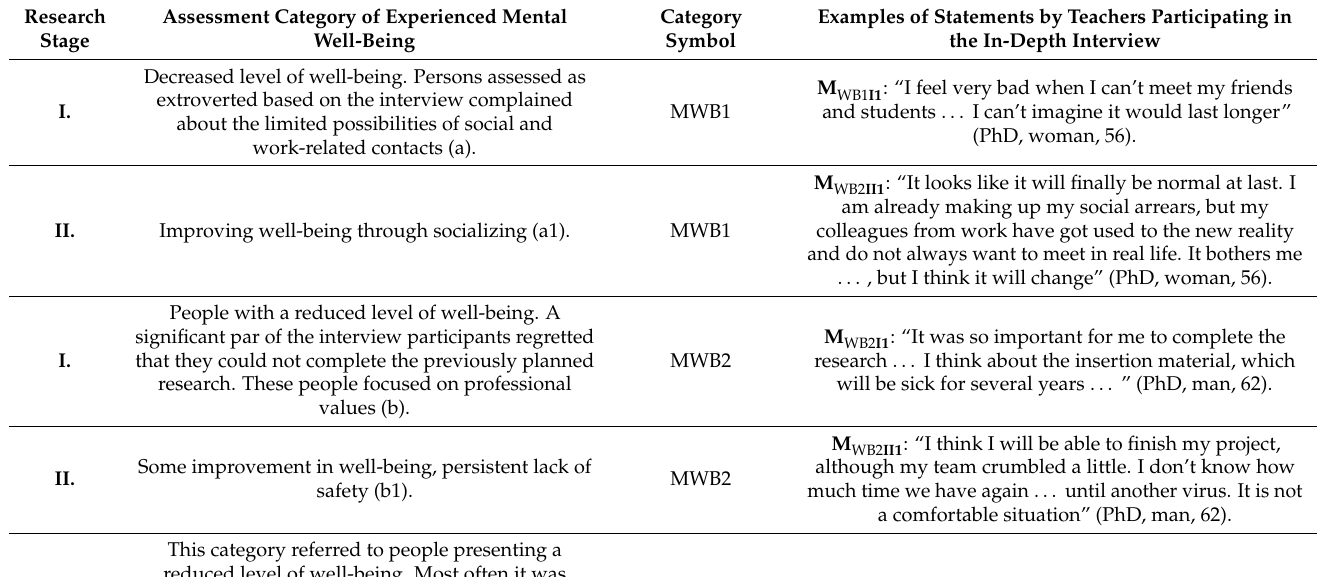
Table 2. Subcategory of the assessment of the experienced well-being by academic teachers in connection with taking up remote work during the epidemic of COVID-19. Source: own